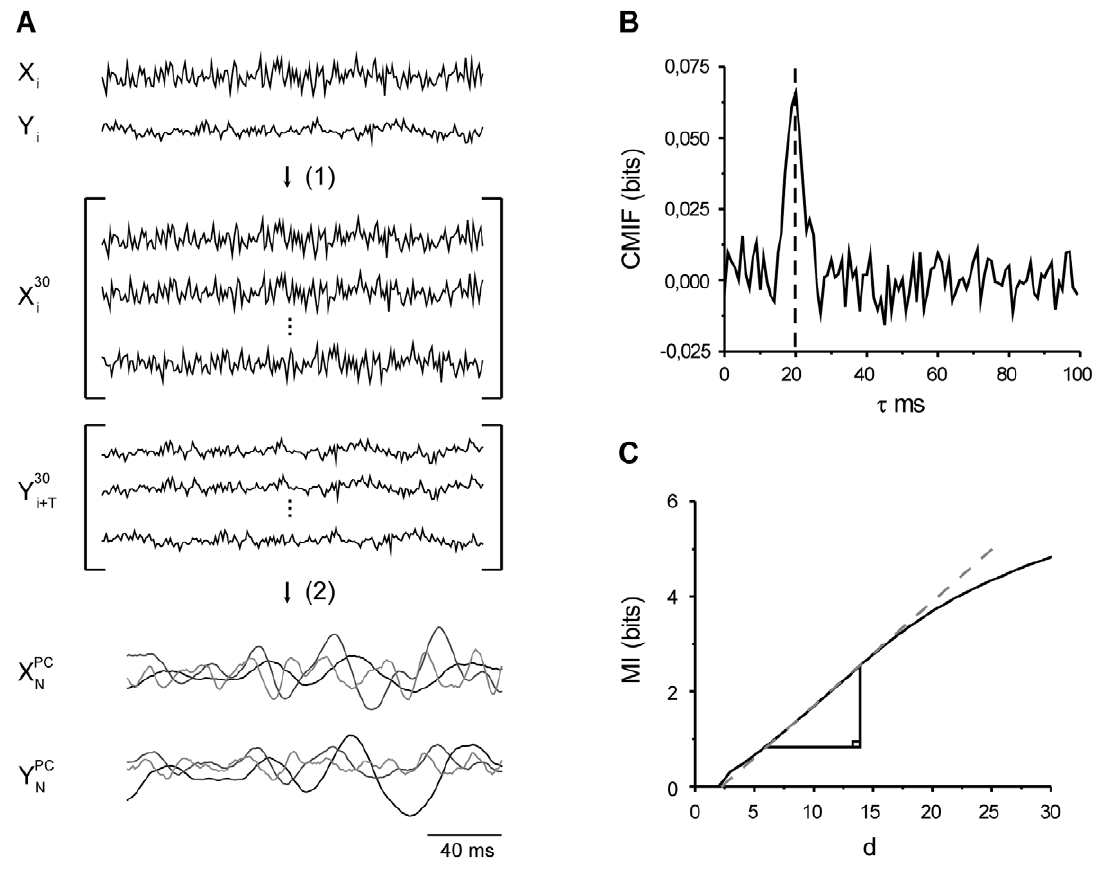
Figure 1. Illustration of the steps involved in the information rate estimation. A , Sections of simulated input, X, and output, Y; (1) input and time-delayed output with d=30; (2) the three largest principal components used for the MI estimate. B , CMIF with T=20 ms. C , MI as a function of d; information rate of 220 bits/s was obtained from the linear fit (grey). Graph corresponds to the 4 th data point in Figure 2.